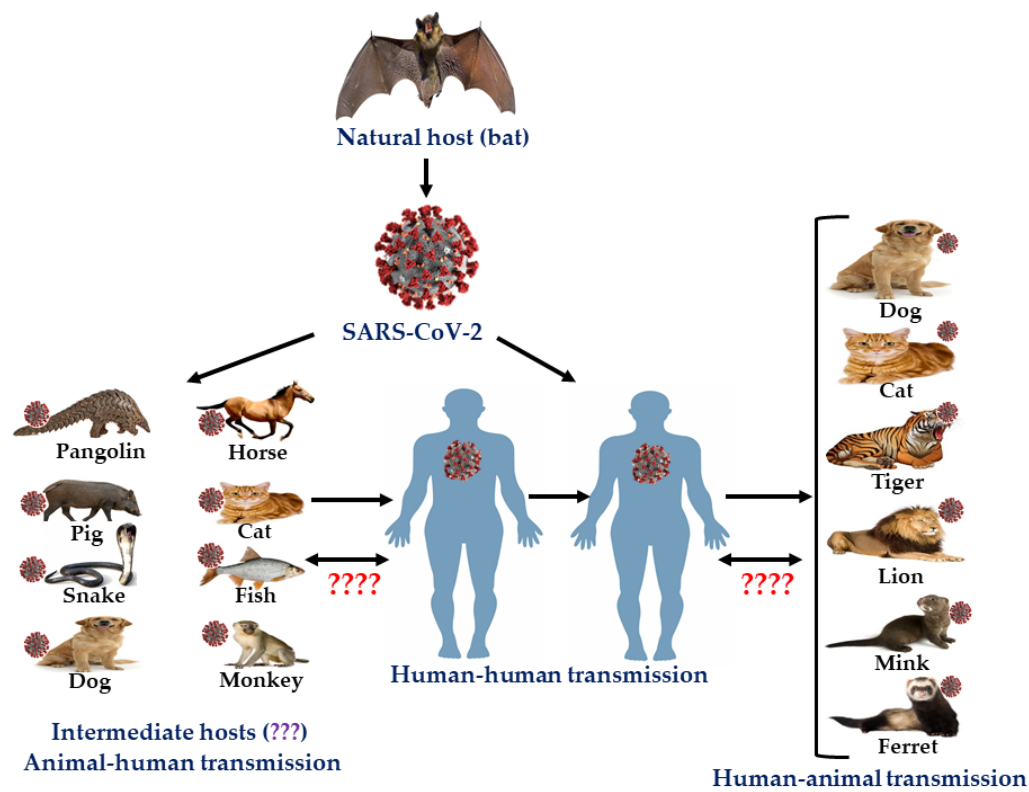
Figure 2. Zoonotic features of SARS-CoV-2 (modified with permission from